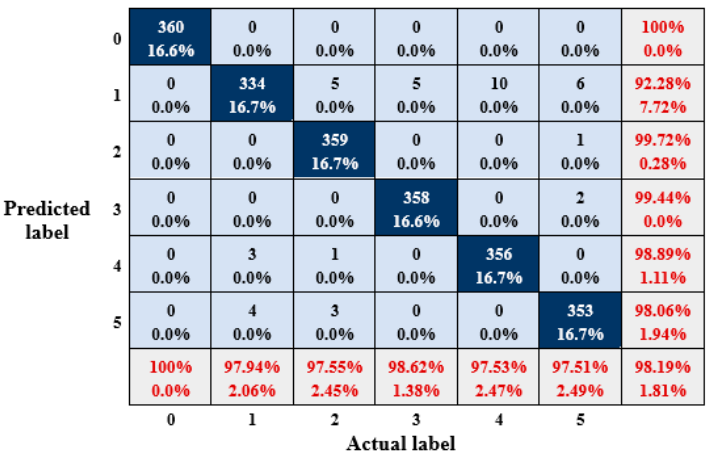
Figure 5. Six fault types of gray scale image. (a) normal condition, (b) inner race fault, (c) outer race fault, (d) cage fault, (e) inner and outer race fault, (f) inner race, ball, cage and outer race fault.